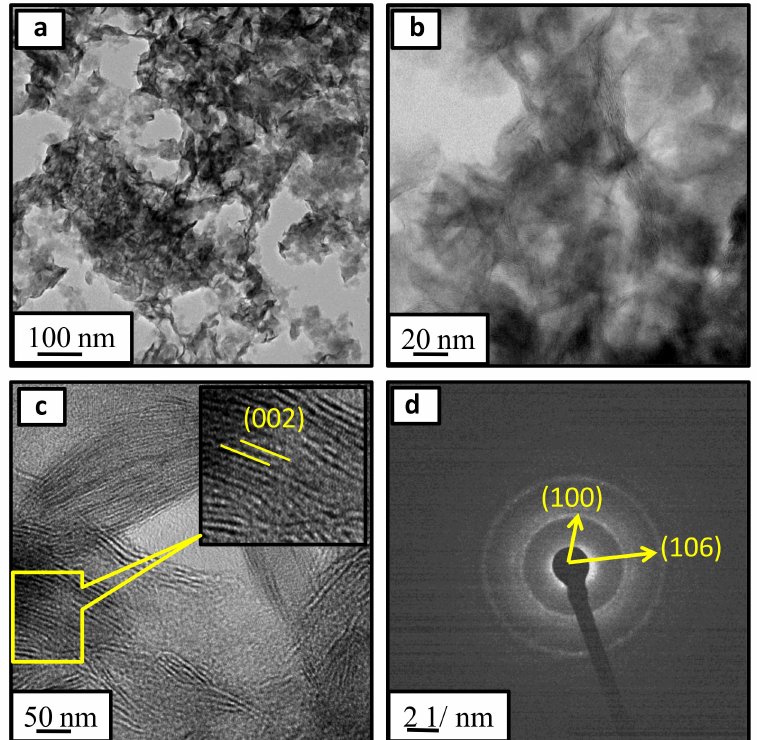
Figure 3. ( a , b ) FETEM of MoS 2 (MS-2) at different magnifications; ( c ) FETEM of the individual MoS 2 layer; ( d ) corresponding selected area electron diffraction SAED